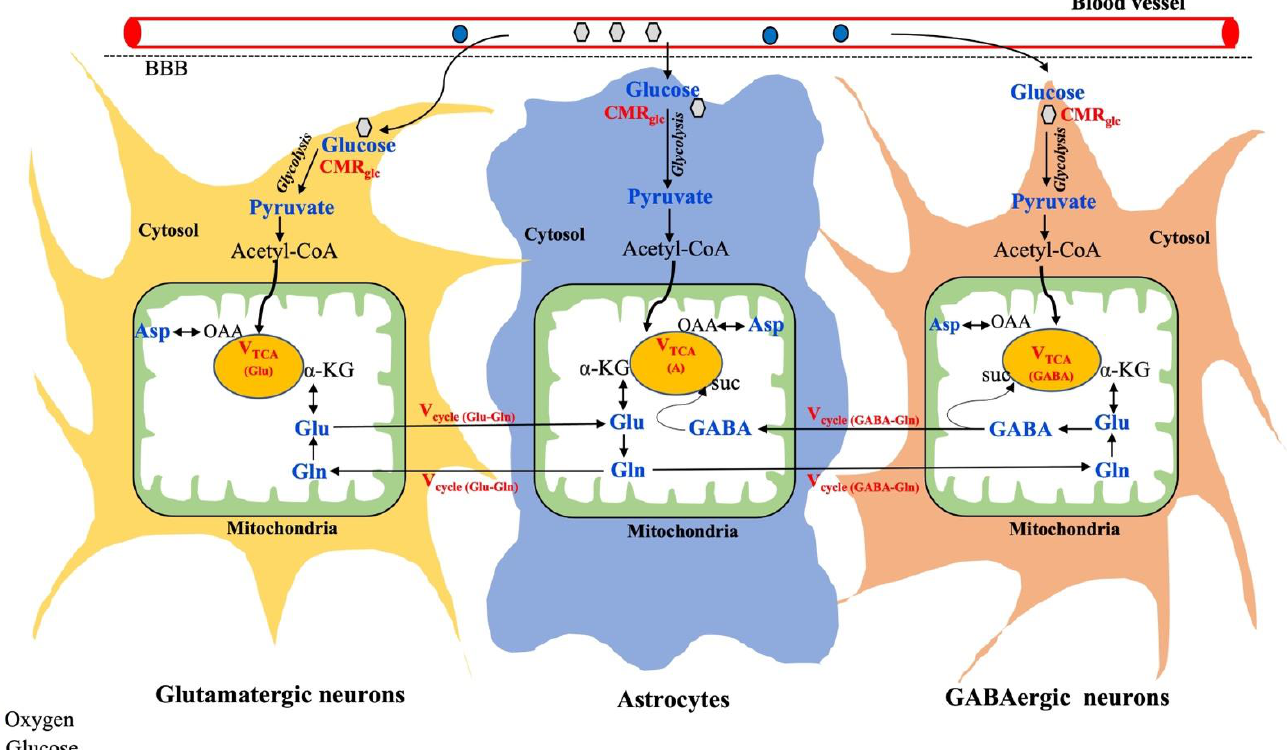
Figure 3. Overview of metabolic interactions between neurons (glutamatergic and GABAergic) and astrocytes. Metabolic fluxes/cycles that can be measured by 13 C-MRS are highlighted in red color. Suc, Succinate; OAA, Oxaloacetate. Adapted from the publication [106],with permission. Further, neurons are broadly classified into two categories based on neuronal activ- ity: Glutamatergic neurons are the most abundant (80%) and involved in excitatory activ- ity. GABAergic neurons are less abundant (20%) and responsible for inhibition [57]. As